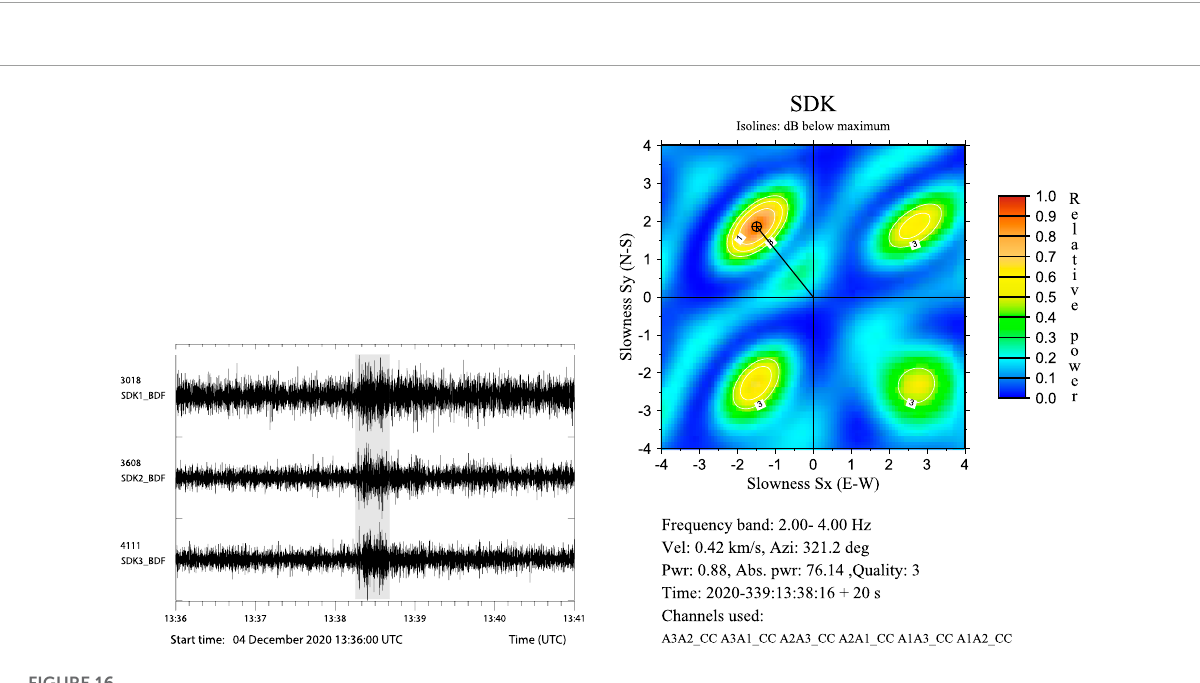
FIGURE 16 Infrasound observations from the Sodankylä SDK infrasound monitoring station. Left: Infrasound signals, Right: Slowness-space estimate of power for the time segment highlighted in gray on the left figure.